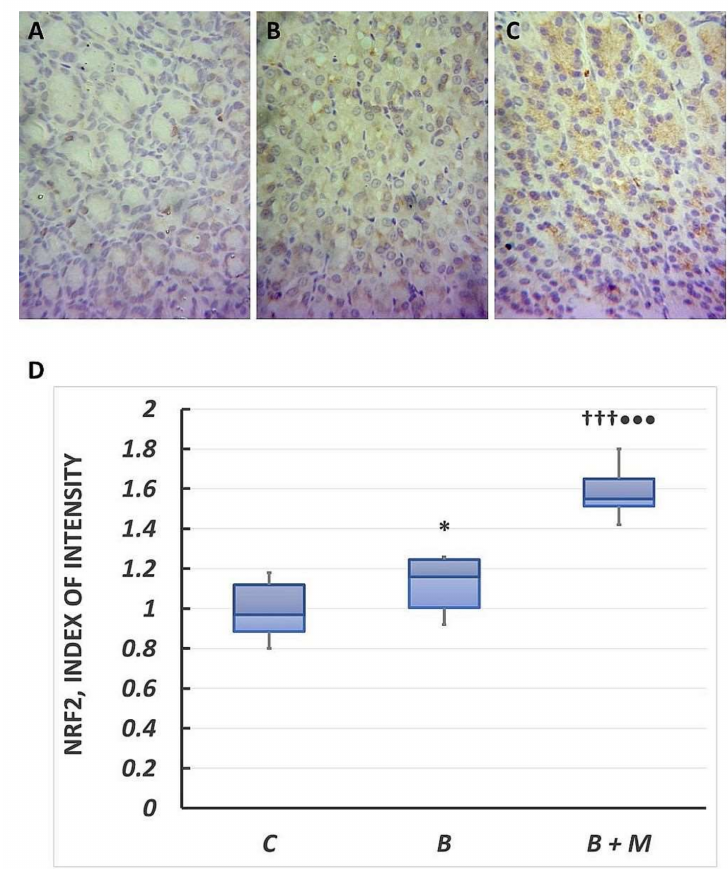
Figure 5. Melatonin effect on Nrf2 protein expression. Immunohistochemical Nrf2 detection in gastric mucosa. Controls ( A ); burned rats ( B ); burned rats, treated with melatonin ( C ). The antigen site appears as a brown color. Representative images. Original magnification, 400 × . Score index of Bax positive immunostained cells ( D ). Results are given as box plot, with median, 25th- and 75th-percentile values, and min and max values. * p < 0.05 vs. control group; ††† p < 0.001 vs. burned, non-treated group; ••• p < 0.001 vs. control group. Controls (C); burned rats (B); burned melatonin-treated rats (B +